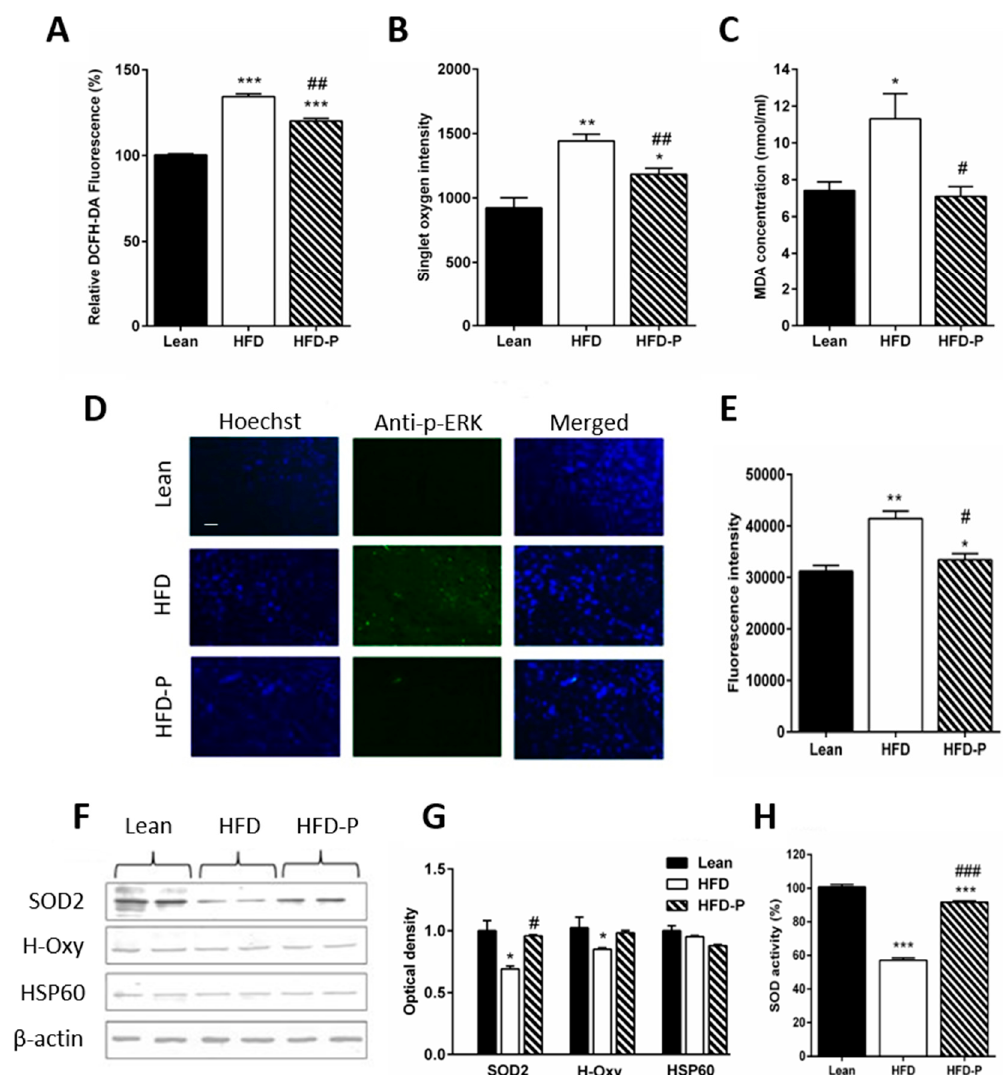
Figure 4. Pistachio consumption prevents HFD-induced brain oxidative stress. ( A ) levels of ROS in brain tissue of lean, HFD or HFD-P fed mice measured by DCFH-DA assay (% respect to STD); ( B ) 1 O 2 Figure 4. intensity; ( C ) lipid peroxidation levels in brain tissues of lean HFD or HFD-P fed mice measured by MDA assay; ( D ) immunofluorescence of cerebral cortex sections of lean, HFD, and HFD-P mice incubated with anti-phosho-ERK; ( E ) quantification of p-ERK immunofluorescence; ( F ) Western blot of proteins extracted from lean, HFD, HFD-P brain lysates, and incubated with anti-SOD2, anti-H-Oxy, and anti-HSP60. Uniformity of gel loading was confirmed by β -actin as standard; ( G ) densitometric analysis of immunoreactivity; ( H ) total SOD2 activity levels expressed as % respect to lean in each tissue extract. Data are means ± SEM ( n = 8 / group). * p < 0.05, ** p < 0.01, *** p < 0.001 vs STD. (# p < 0.05, ## p < 0.01, ### p < 0.001 vs HFD. Microscope magnification 20 × . Bar: 100 µ